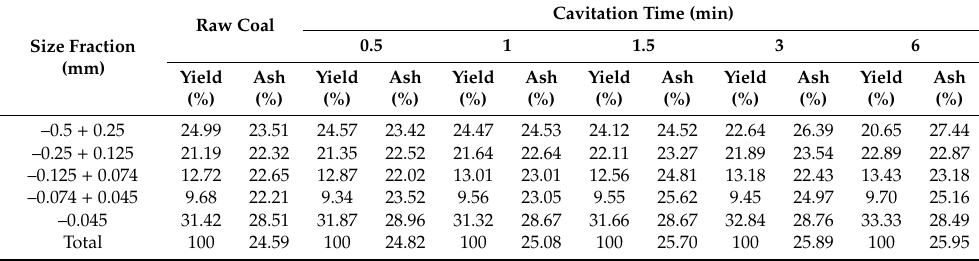
Table 4. Comparison of screening results of coal samples under different cavitation time.